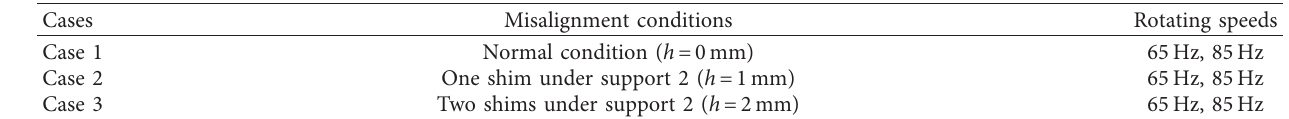
Figure 9: First two order natural frequencies and modes of the rotor system. (a) The 1 st order (76.3 Hz). (b) The 2 nd order (116.43Hz). Table 4: Operating conditions.